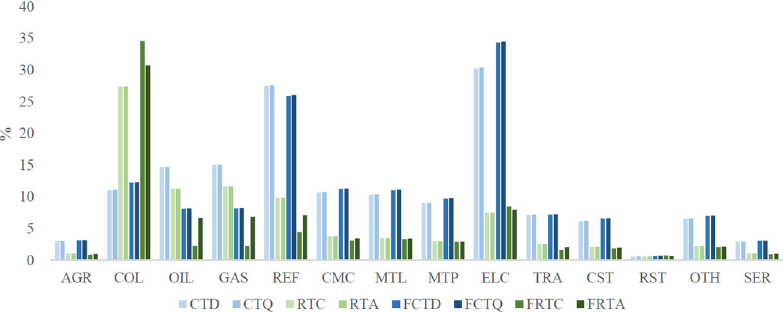
Fig. 6 Commodity price changes in 2030. Blue bars are scenarios imposing carbon taxes, and green bars are scenarios imposing resource taxes. Deeper colors represent free market condition in these scenarios. Please refer to Table 2 for industry abbreviations.